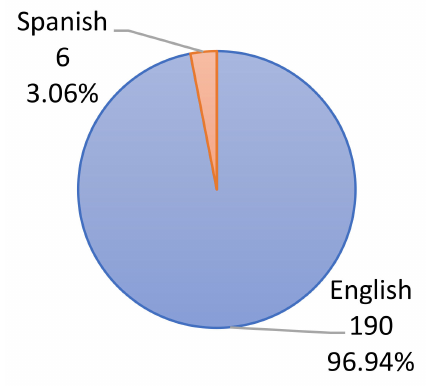
Figure 9. Language